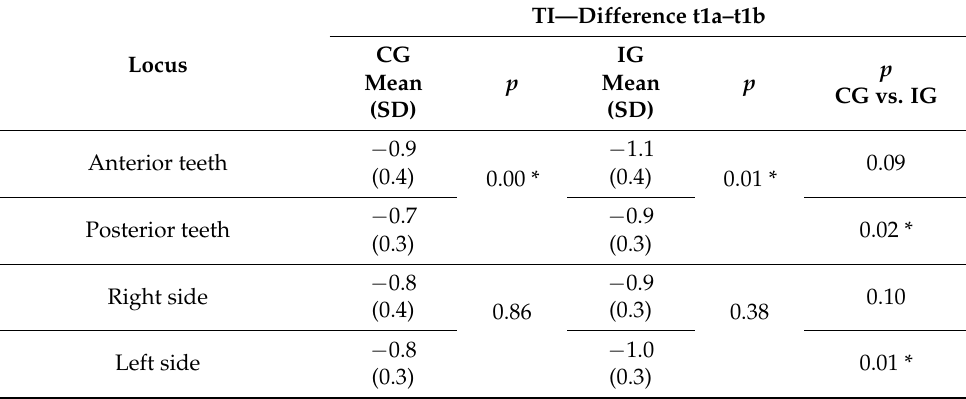
Table 7. Dental plaque reduction rates in IG and CG after autonomous tooth brushing at different